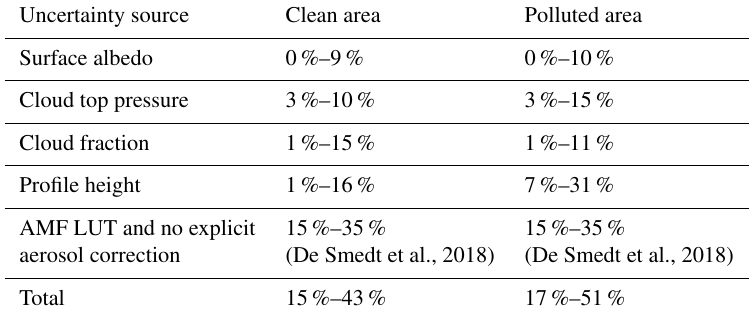
Table 4. Uncertainties of TROPOMI HCHO VCD from the parameters used in AMF calculation. Uncertainties are estimated with a fixed set of observation geometry (SZA = 30 ◦ , VZA = 30 ◦ , RAA = 0 ◦